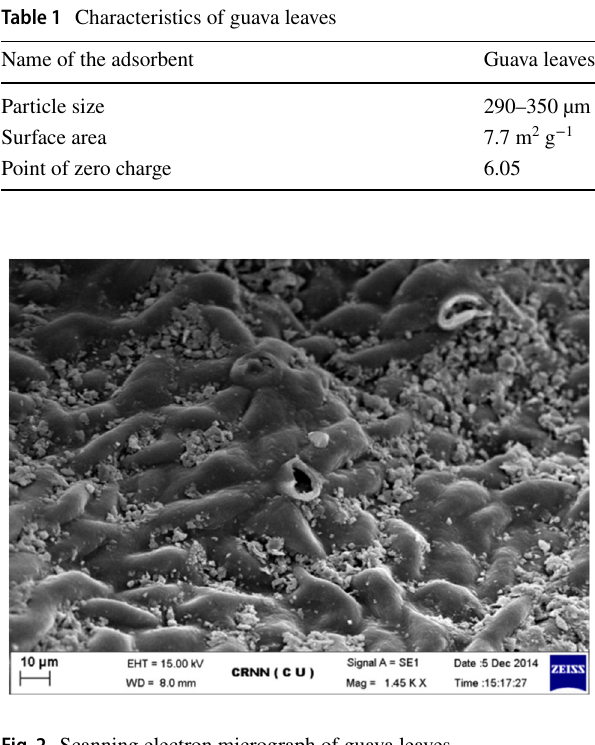
Fig. 2 Scanning electron micrograph of guava